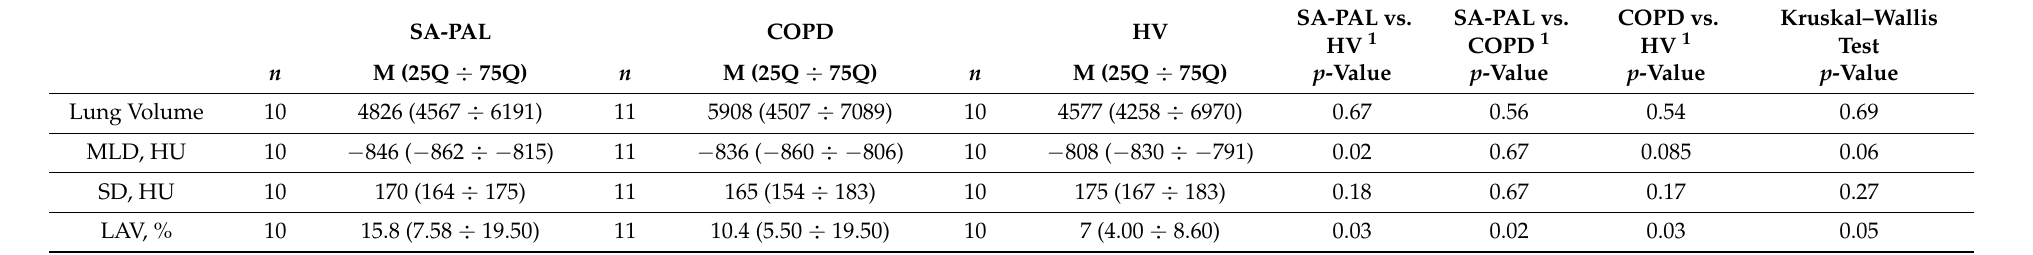
Table 3. Lung parenchyma parameters in the SA-PAL, COPD, and HV